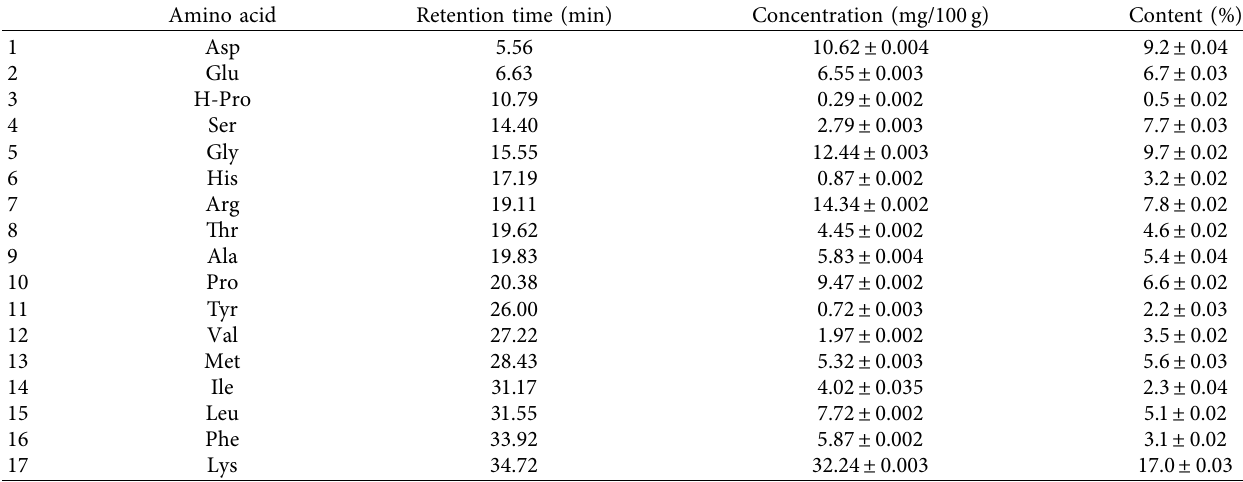
Table 1: Amino acids’ profile of tunichrome released from Phallusia nigra Persian Gulf marine tunicate by HPLC. Amino acid Retention time